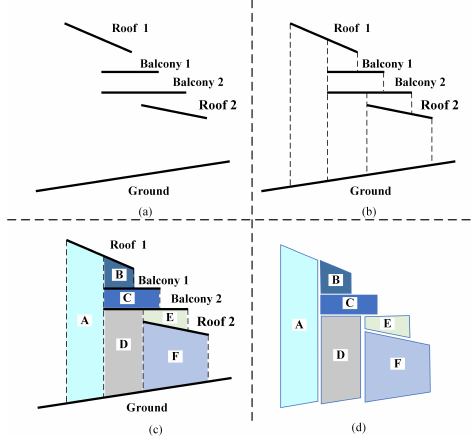
Figure 6. Side view of top-bounded spaces extraction with inclined components (surfaces).